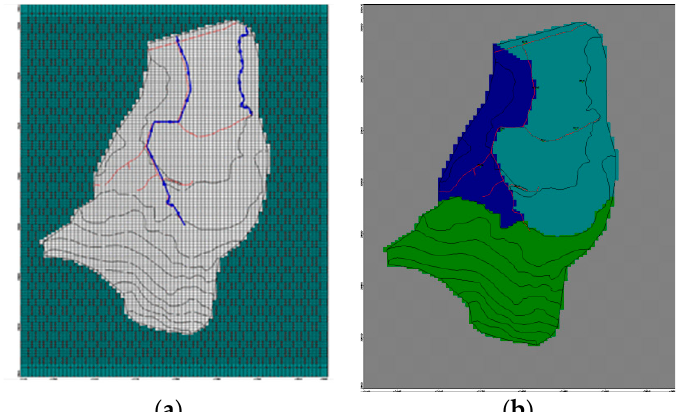
Figure 4. The ( a ) boundary conditions and ( b ) hydraulic conductivity values in the hilly zone (green color), the residential zone (blue color), and the agricultural zone (blue-green color). Table 11. The input values of the hydraulic parameters for the different zones. Zone